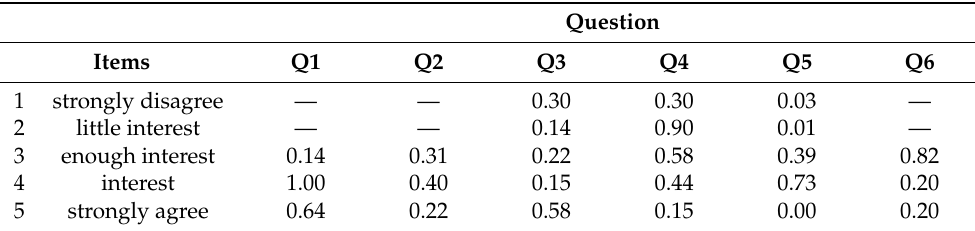
Table 10. Results of the test of proportions between girls and boys aged <12 years